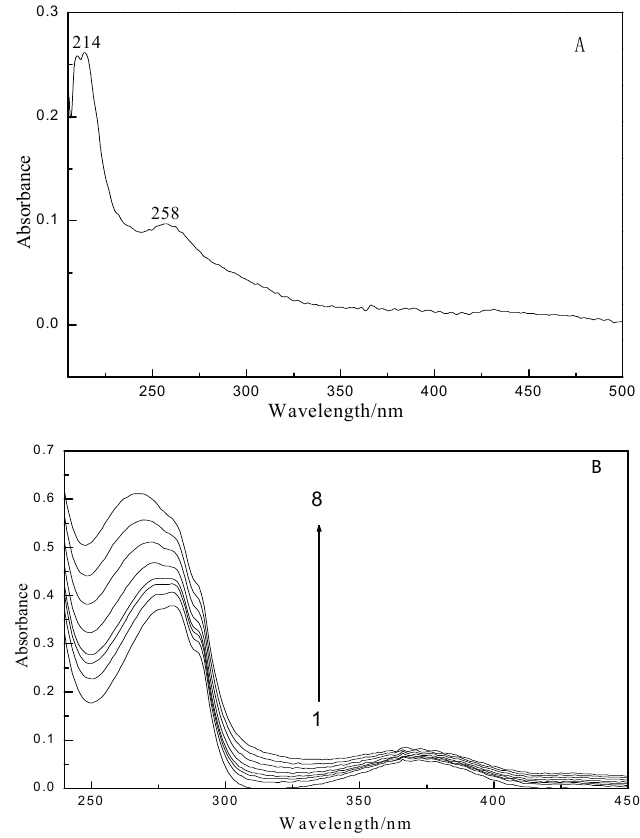
Figure 3. UV absorption spectrum of GA ( A ) and GA-LYS ( B ). Curves (1–8): A series 1.0 mL LYS solution (1.0 × 10 − 5 mol/L) were titrated by adding GA stock solutions with a concentrations from top to bottom were 0.0, 0.4, 0.8, 1.0, 1.6, 2.4, 3.2 and 4 × 10 − 5 mol/L. The UV absorption spectra of GA and GA-LYS system were recorded using a UV-2450 UV-vis spectrometer (Shimadzu Co., Kyoto, Japan).